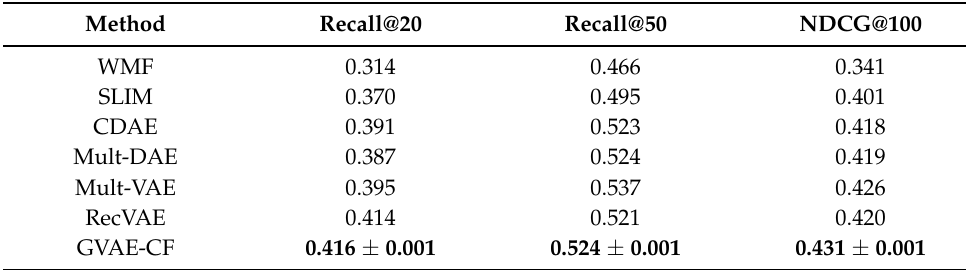
Table 2. Evaluation scores for GVAE-CF and baseline models on Netflix.